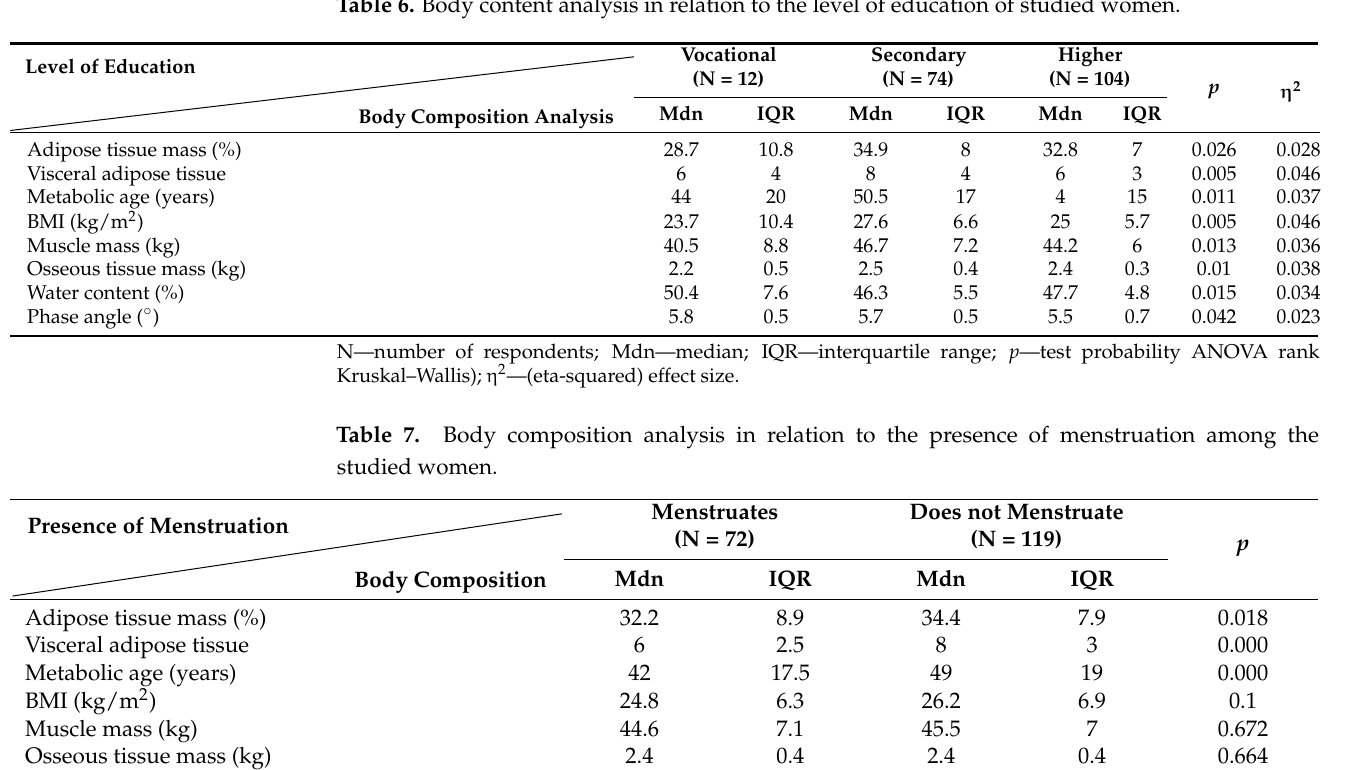
Table 6. Body content analysis in relation to the level of education of studied women.